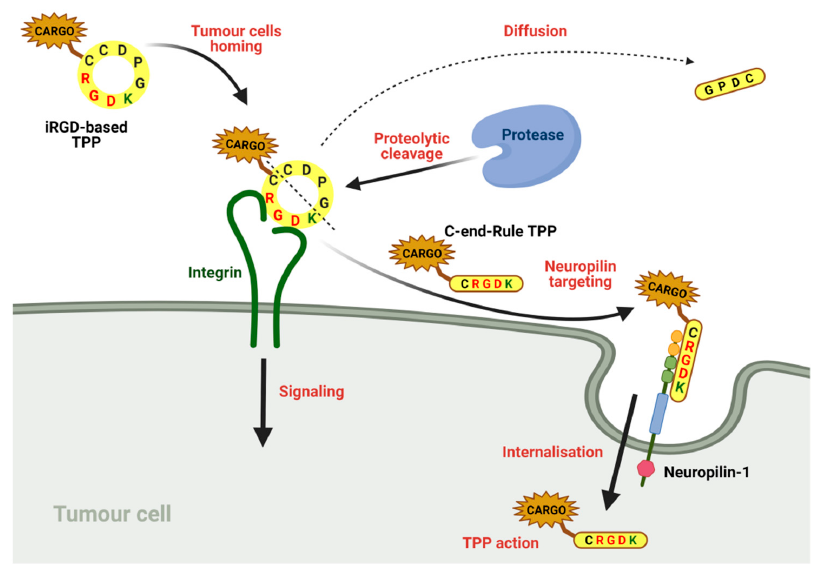
Figure 8. Mechanism of TPP multistep binding and tumour penetration on the example of iRGD